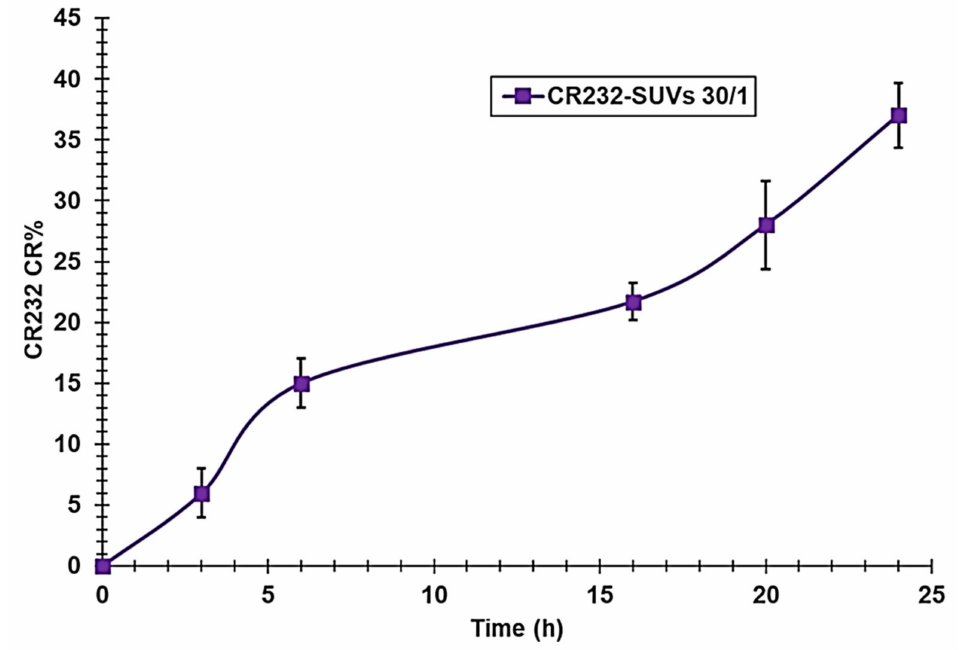
Figure 5. CR232 CR% at pH 7.4 during 24 h obtained by dialysis of freeze-dried CR232-SUV 30/1 dissolved in